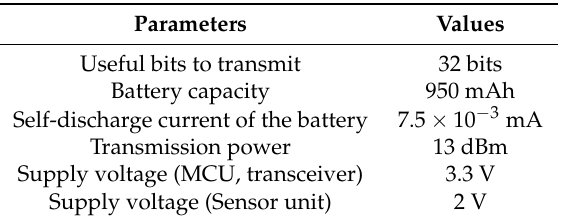
Table 4. Parameters of the application.